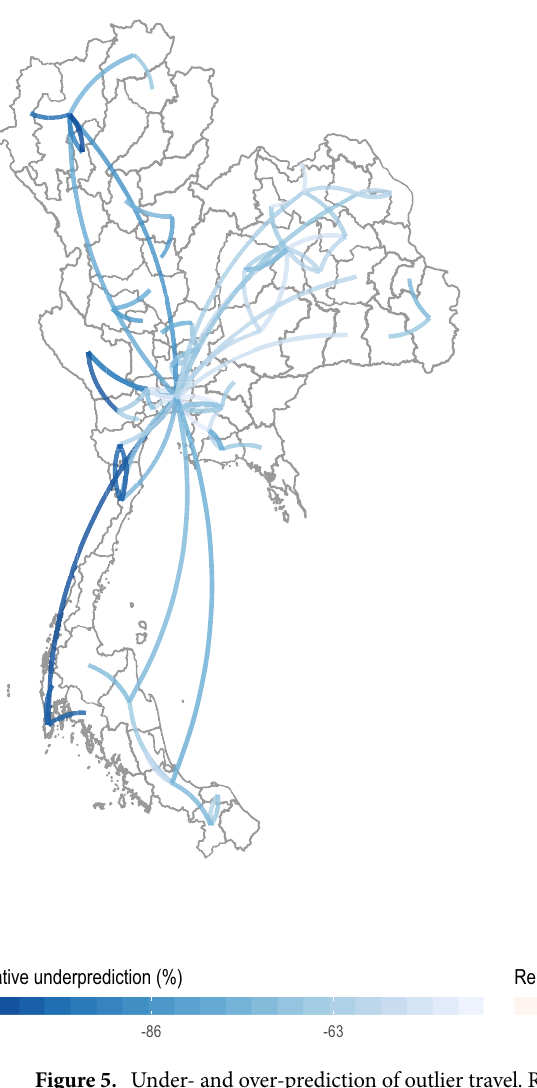
Figure 5. Under- and over-prediction of outlier travel. Relative under-prediction (left) and over-prediction (right) comparing observed mobility data (from CDRs) to estimated mobility data from the best fit gravity model. We defined relative prediction error as 100%*(PredictedTrips − ObservedTrips)/ObservedTrips. We highlight only observations with Cook’s distance greater than five times the average Cook’s distance. Note that Bangkok (center of the map) is central to much of the over- and under-prediction outliers with most over- prediction near Bangkok. All plots were made using ggplot2 55 in R 4.0.1 56